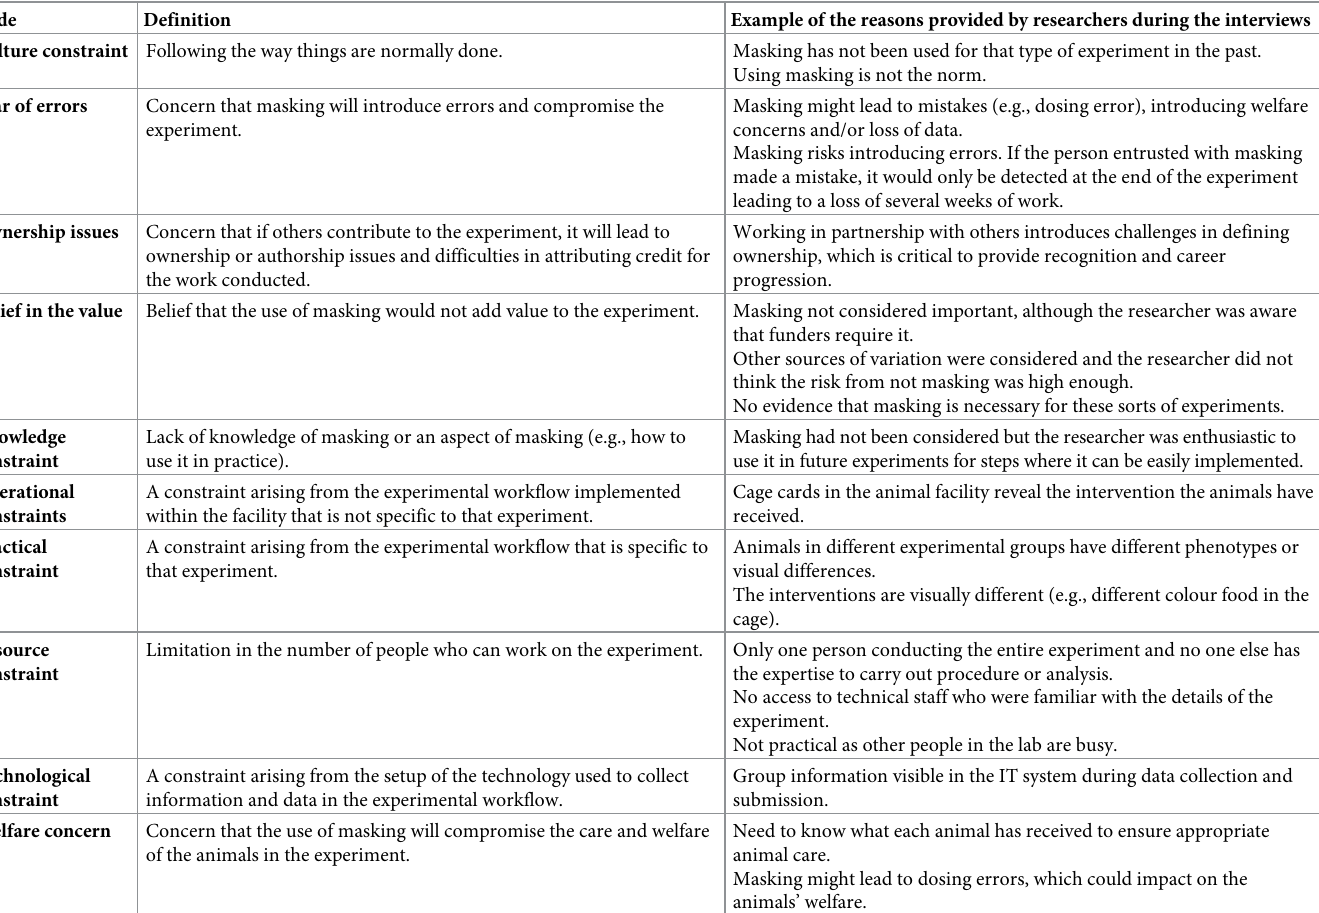
Table 1. Coding developed to classify barriers to masking following inductive iterative discussion of the data from the interviews.